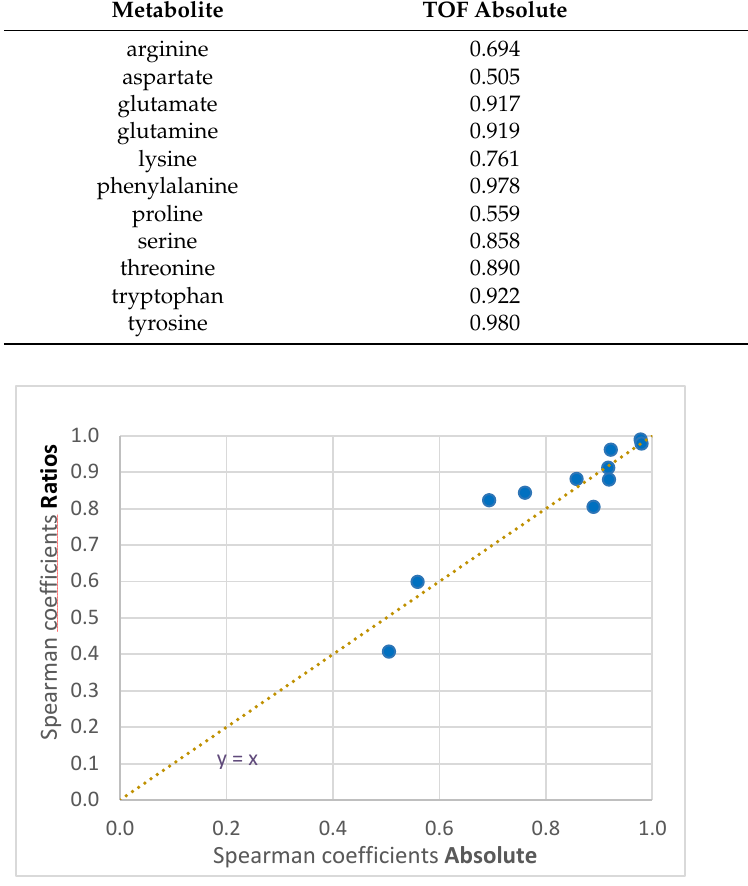
Figure 3. Scatter plot of Spearman correlation coefficients for TOF absolute vs. quant ( x -axis) and TOF ratios vs. quant ( y -axis) of the mutual metabolites between quant and TOF (see Table 2). Note that the dotted line represents the diagonal and not a regression line.